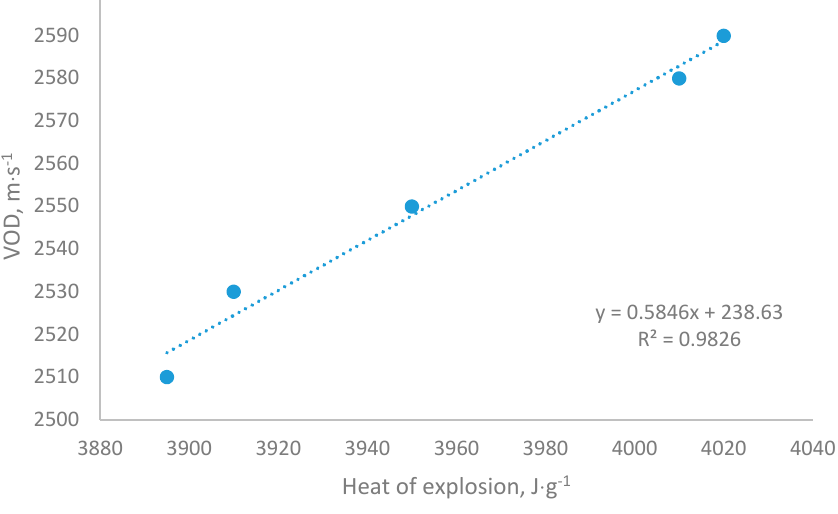
Figure 5. The relation between ANFO’s VOD and heat of the explosion.